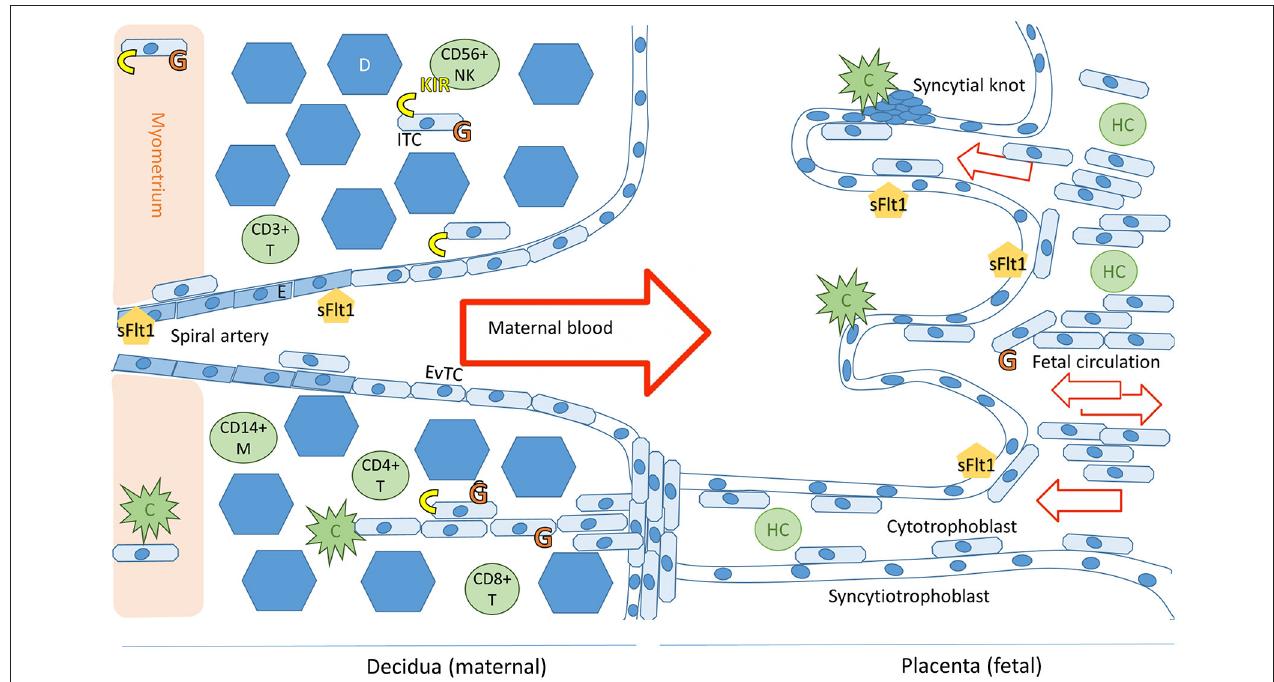
FIGURE 1 | Schematic representation of the maternal-fetal interface and its immunologicalplayers. Trophoblast cells (fetal) and endothelial cells (maternal) express sFlt1. The placental villi are shown in the right side of the image and decidua on the left. Invading trophoblast cells will encounter maternal complement system (C) in the decidua and in the intervillous space. Invading extravillous trophoblasts express HLA-C and HLA-G receptors (in yellow and orange, respectively), expression of HLA-G by villous trophoblast cells in the placenta decreases during the course of the pregnancy (7). Successful trophoblast invasion will extend to the vascular layers of myometrium and invade the uterine spiral arteries, where endovascular trophoblast cells (EvTC) will replace endothelial cells (E) causing remodulation and relaxation of the spiral artery to allow for non-turbulent high volume low pressure circulation into the intervillous space. Interstitial trophoblast cells (ITC) will remain in the maternal tissue creating tolerance of the fetal tissue in the maternal immune system. Hofbauer cells (HC) are the predominant immune cell population in the villi throughout placental development. The decidual immune cell population consists of macrophages (M), natural killer cells (NK), and populations of T-cells (T). Tolerance inducing Treg and Breg cells in particular are essential for a healthy pregnancy ( 8). Figure adapted from Lokki 2017 PhD thesis (9).